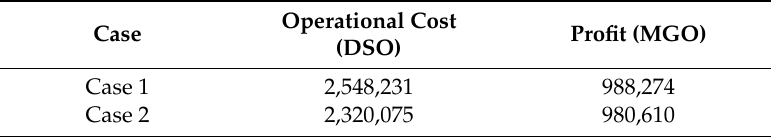
Table 9. Comparison optimal results for each case.